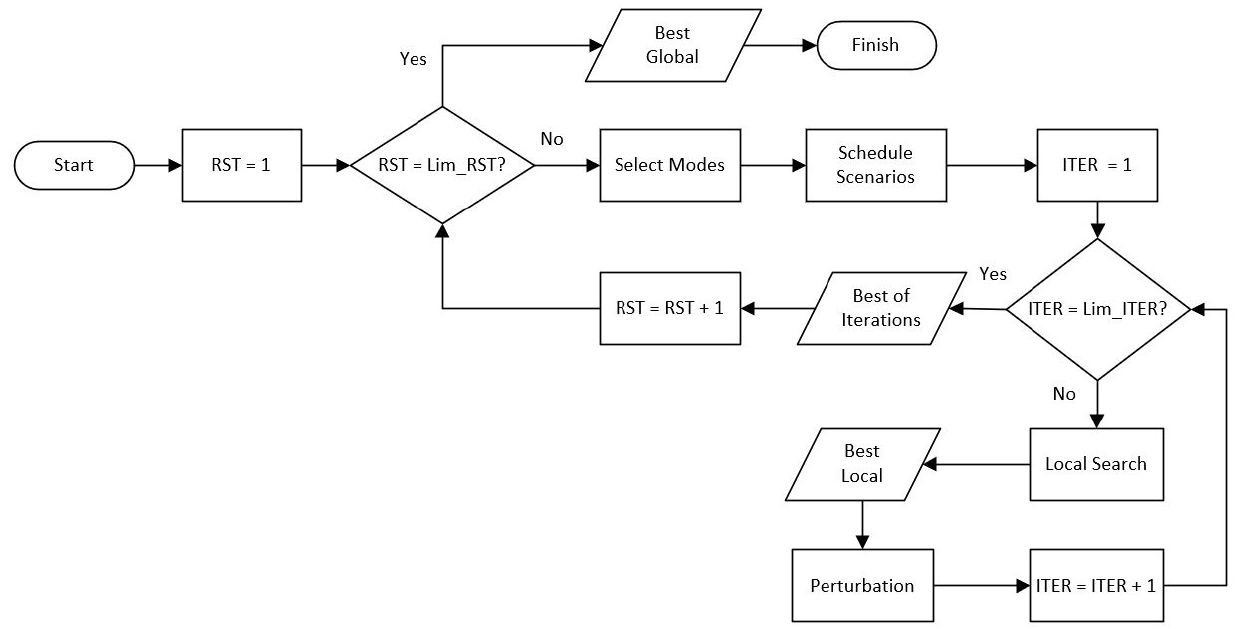
Figure 2. Flowchart of the multi-start iterated local search. ITER = Iterations, RST =